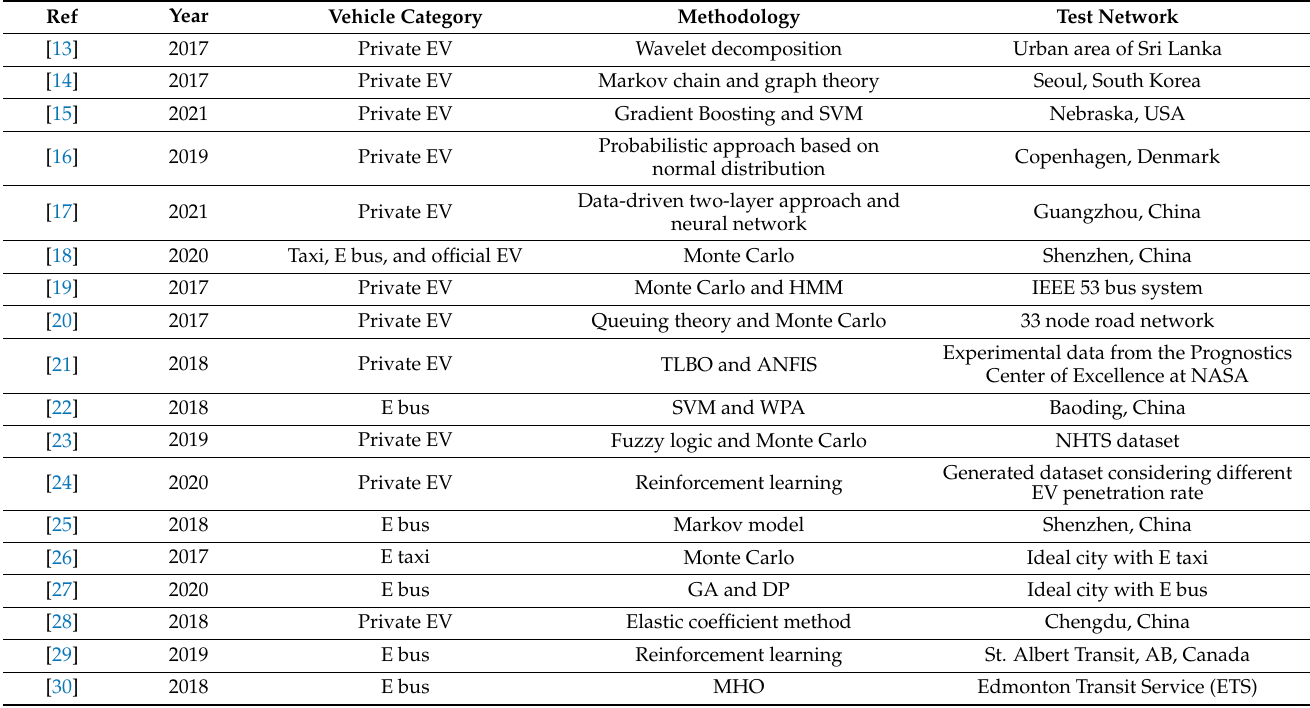
Table 1. Review of research works on the prediction of charging